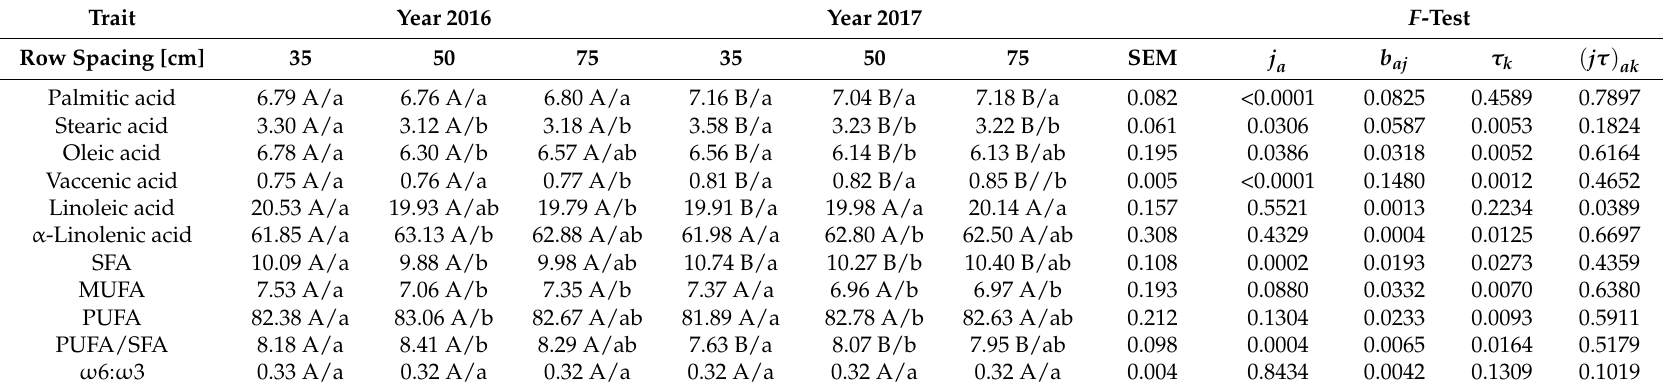
Table 6. Mean estimates of fatty acid composition (% of total fatty acid) of chia (genotype G8) cultivated in three different levels of row spacing (35, 50, 75 cm) at Ihinger Hof in 2016 and 2017, along with standard error of the mean (SEM) and F -tests.